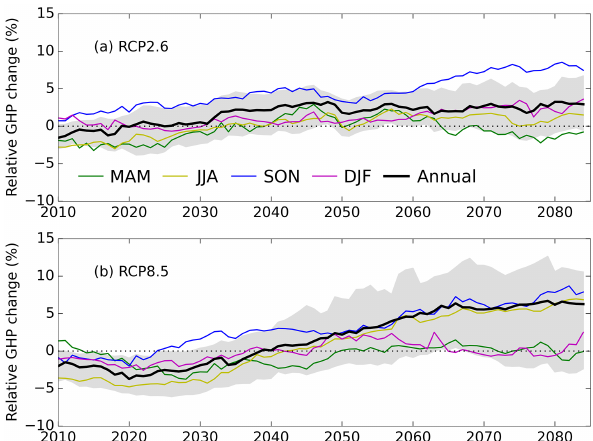
Figure 3. Medians of relative changes in the GHP of China over the 2010–2084 period under RCP2.6 (a) and RCP8.5 (b) . Solid lines show the ensemble medians of GHP; grey areas denote the IQRs